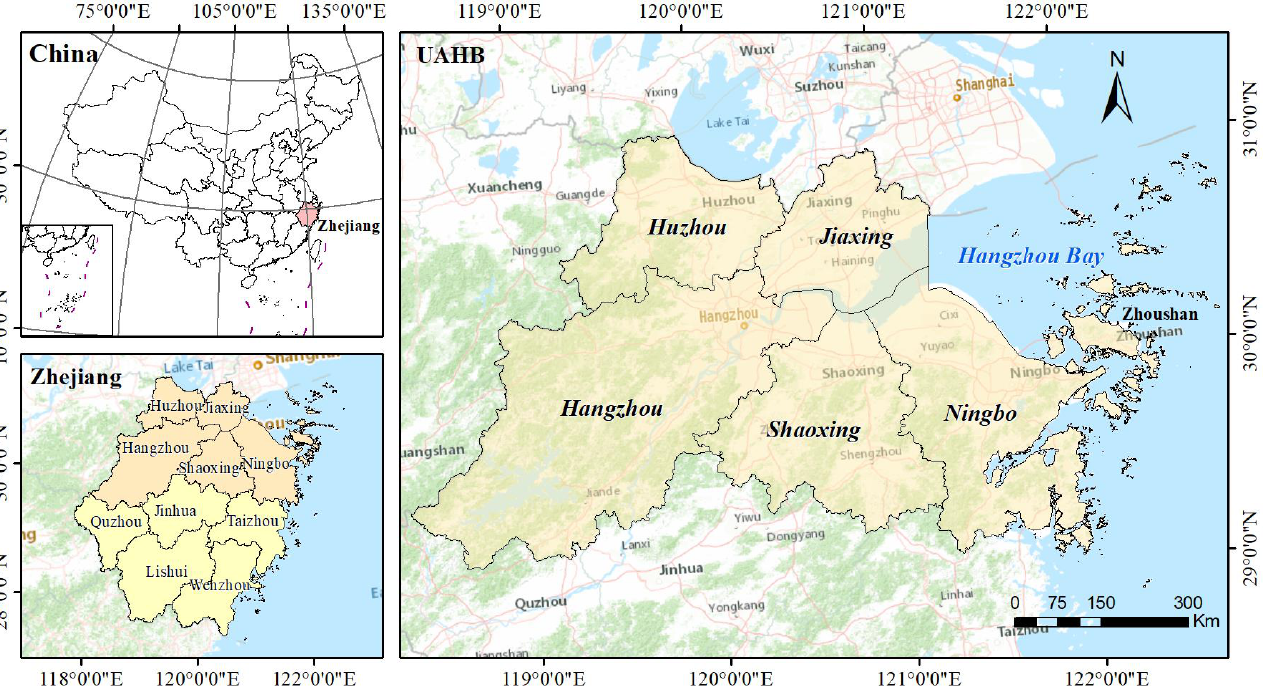
Figure 1. Location of the UAHB in Zhejiang Province, China.